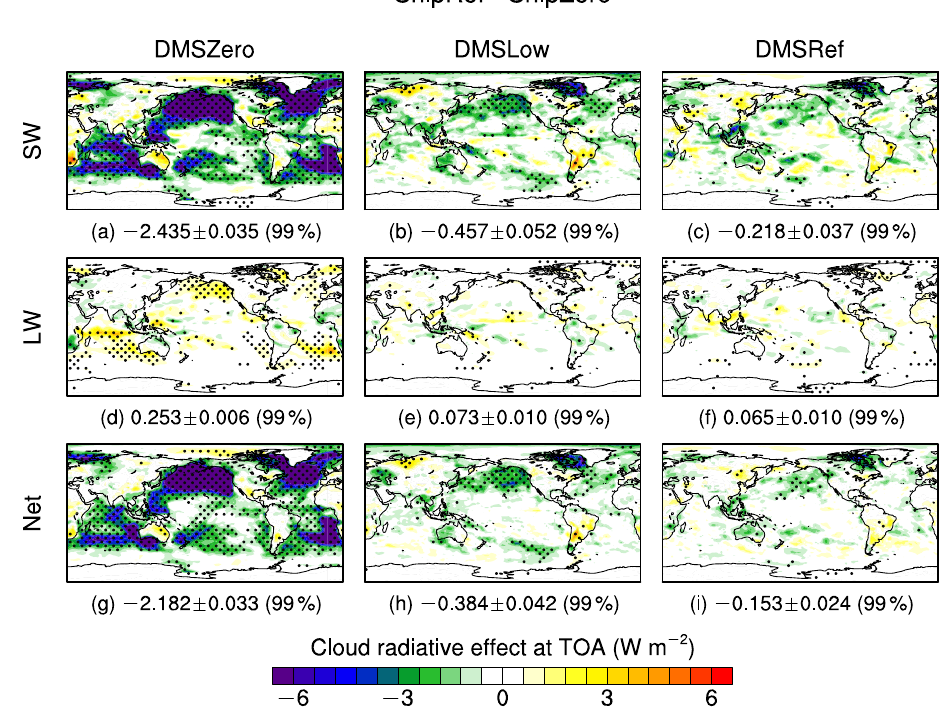
Figure 6. Spatial patterns of MARC-simulated cloud radiative effect (CRE; Wm − 2 ) at the TOA of ISE at various DMS emission levels. The CRE is calculated as the differences of radiation flux at the TOA and at all-sky conditions between the simulation without shipping emissions and three simulations with the same shipping emissions at the reference level but various DMS emission levels (i.e., zero, low, and reference) in short-wave (SW), long-wave (LW), and net (SW + LW) radiation and averaged over the 30-year simulation period. The numbers below each panel are the global means, standard deviation across the 30-year period, and the confidence level. The black dots represent grid points that are statistically significant above the 90% confidence level based on the two-tailed Student’s t